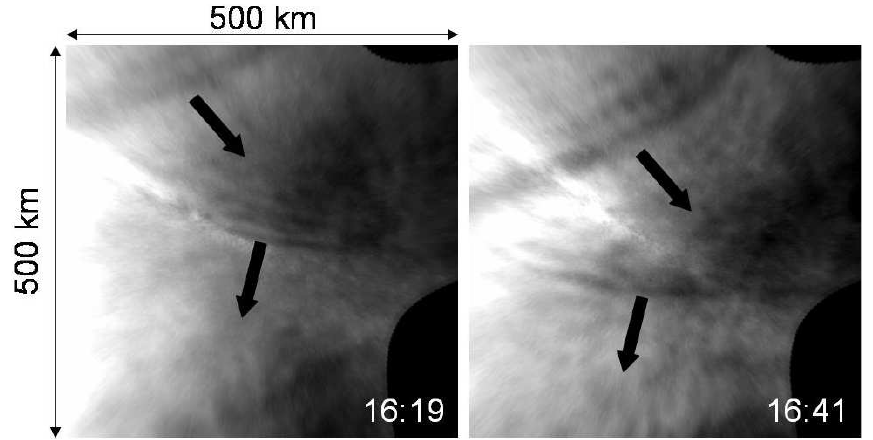
Fig. 3. Examples of fully processed images in the OH emission at two different times on the night of 27 January. The images were unwarped onto a 500 × 500km geographic grid. The two wave events observed on this night are present in both images and their motions are indicated by the arrows.